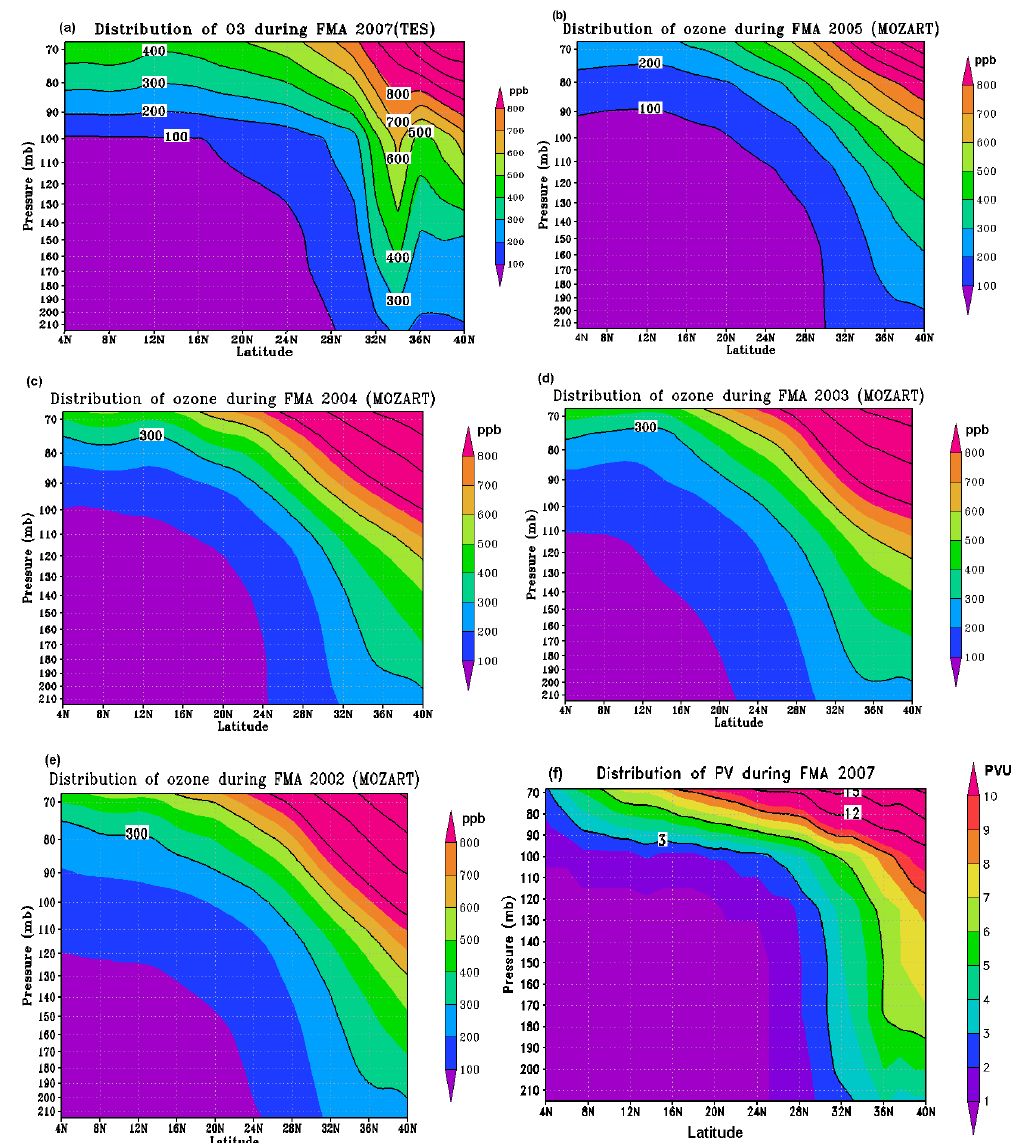
Fig. 5. Latitude-height cross section of zonal (averaged over the longitudes 65–100 ◦ E) and seasonal (February-March-April months) mean ozone mixing ratio as obtained from (a) analysis of TES observations for the year 2007; (b) analysis of MOZART model simulation for the year 2005; (c) analysis of MOZART model simulation for the year 2004; (d) analysis of MOZART model simulation for the year 2003; (e) analysis of MOZART model simulation for the year 2002; (f) latitude-height cross section of zonal (averaged over the